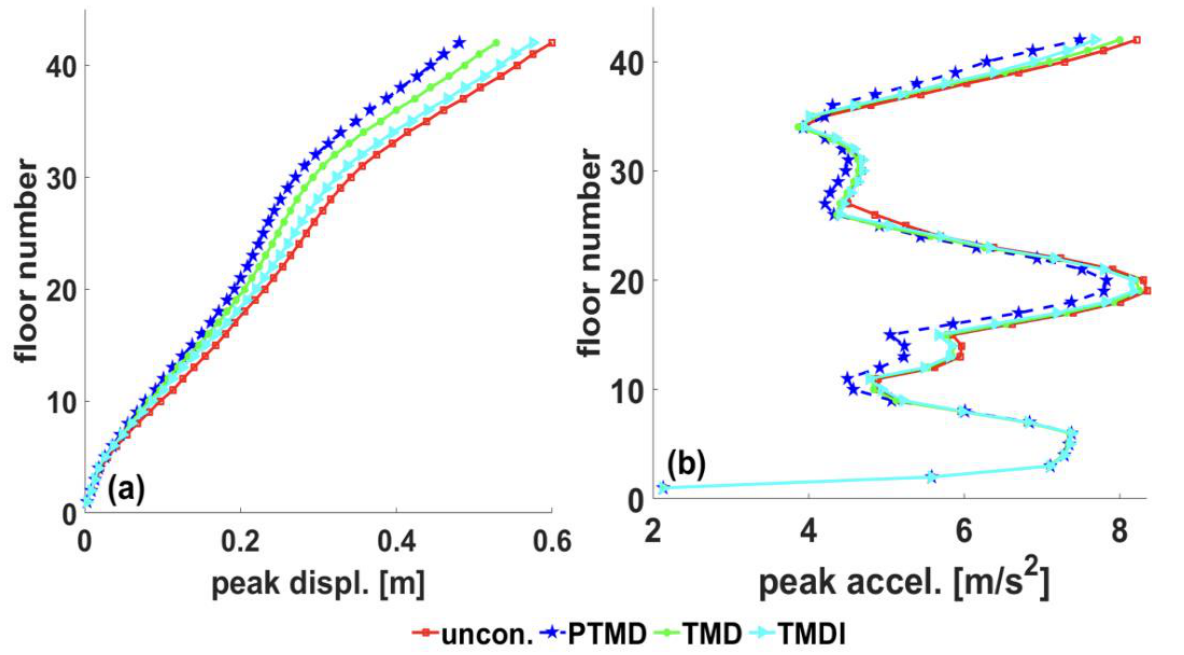
Figure 19. Floorwise responses under El-Centro earthquake: ( a ) peak displacement, ( b ) peak accel- eration.